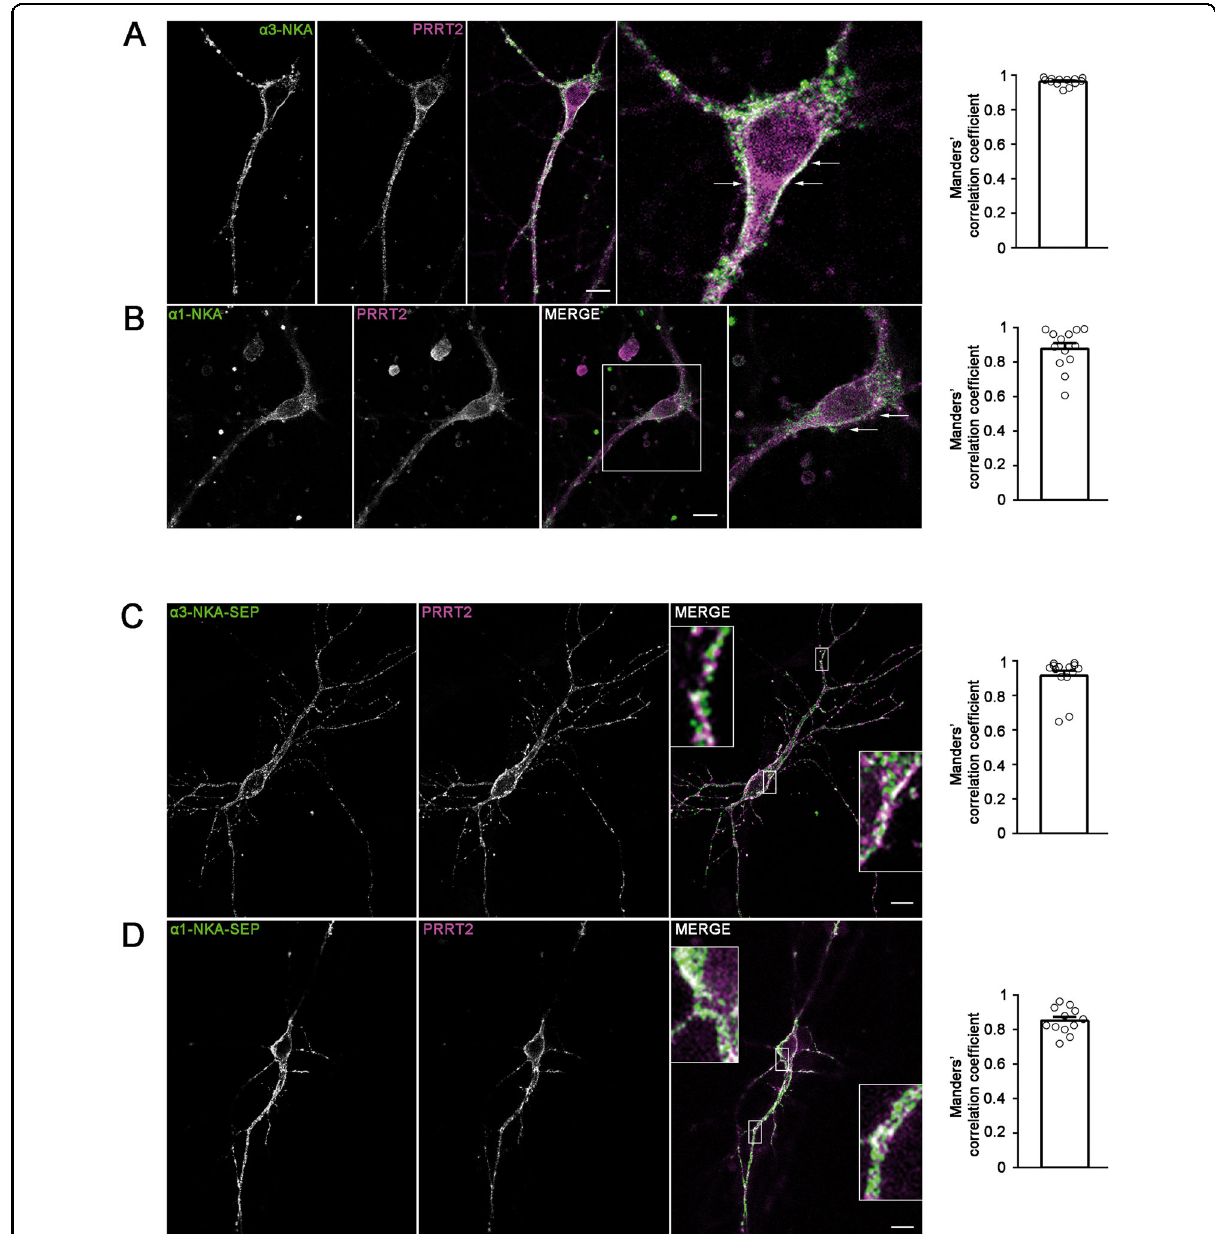
Fig. 2 Co-localization of α 3-NKA and α 1-NKA with PRRT2 in primary hippocampal neurons. A , B Hippocampal neurons (DIV 14) were stained for endogenous PRRT2 and either α 3-NKA ( A ) or α 1-NKA ( B ). Left: Representative confocal images show the overlapping staining of NKA isoforms and PRRT2 (magni fi ed in the insets). Scale bar, 10 μ m. Right: Quantitative evaluation of the extent of the codistribution between PRRT2 and NKA isoforms using the Manders ’ correlation coef fi cient expressing the PRRT2/NAK overlap area in percent of the NAK immunoreactive area (0.96 ± 0.06 and 0.87 ± 0.04 for α 3-NKA/PRRT2 and α 1-NKA/PRRT2, respectively; n = 15 images from three independent experiments). C , D Hippocampal neurons transfected with PRRT2-HA and either α 3-NKA-SEP ( C ) or α 1-NKA-SEP ( D ) were live-labeled (DIV 14) with anti-HA and anti-GFP antibodies to stain the surface- exposed domains of the proteins. Left : The images show the largely overlapping staining of PRRT2 with both α 3-NKA-SEP and α 1-NKA-SEP (magni fi ed in the insets). Scale bar, 10 μ m. Right: Quantitative evaluation of the extent of the codistribution between PRRT2-HA and the NKA-SEP isoforms using the Manders ’ correlation coef fi cient expressing the PRRT2/NAK overlap area in percent of the area of NAK fl uorescence (0.91 ± 0.04 and 0.84 ± 0.03 for α 3-NKA/PRRT2 and α 1-NKA/PRRT2, respectively; n = 15 images from three independent experiments).